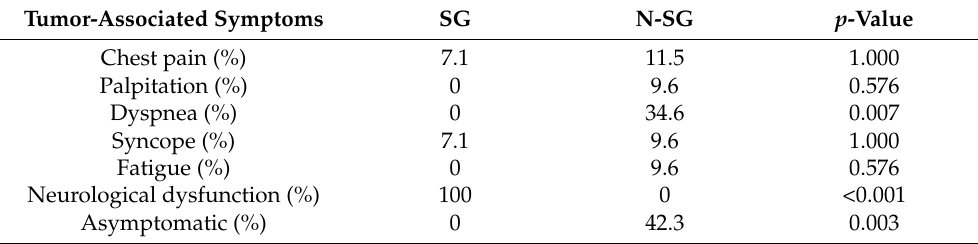
Table 4. Tumor-associated